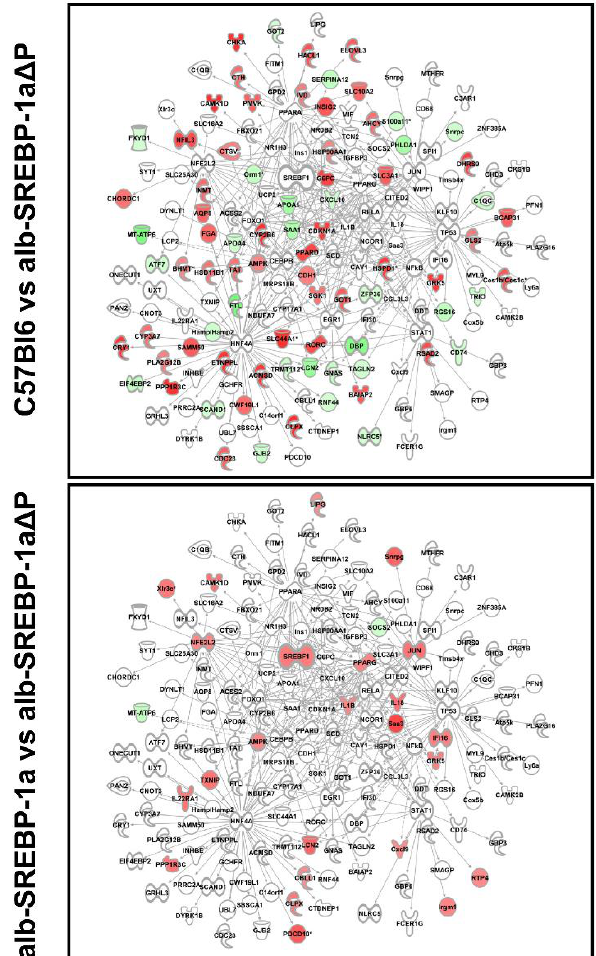
Figure 4. Differential regulation of SREBP-1-centered genes in the comparisons C57Bl6 vs. alb-SREBP-1a, C57Bl6 vs. alb-SREBP-1a∆P, and alb-SREBP-1a vs. alb-SREBP-1a∆P. Genes with differential gene expression (1.5-fold, p -value < 0.05) were used for IPA Core analyses. Genes in the SREBP-1 network were analyzed for differential expression in the comparisons C57Bl6 vs. alb-SREBP-1a, C57Bl6 vs. alb-SREBP-1a∆P, and alb-SREBP-1a vs. alb-SREBP-1a∆P. Color code indicates: red: increase in condition 1, green: decrease in condition 1 based on measured expression differences.